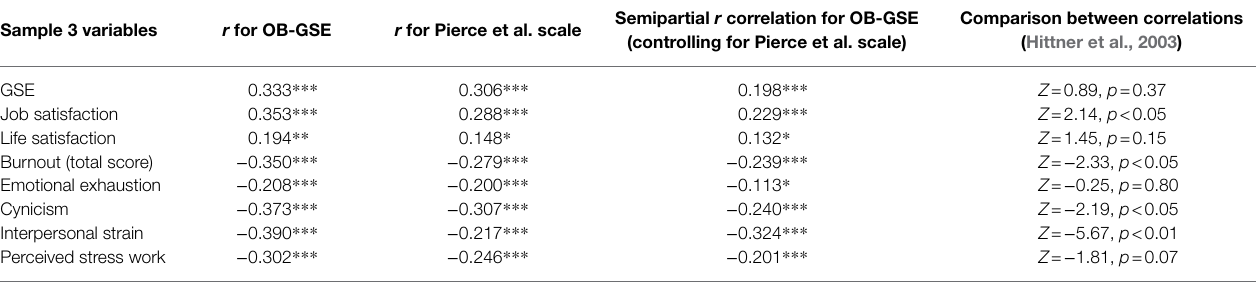
TABLE 5 | Zero-order correlations and comparison between OB-GSE, Pierce et al. OBSE scale and Sample 3 variables. Sample 3 variables r for OB-GSE r for Pierce et al. scale